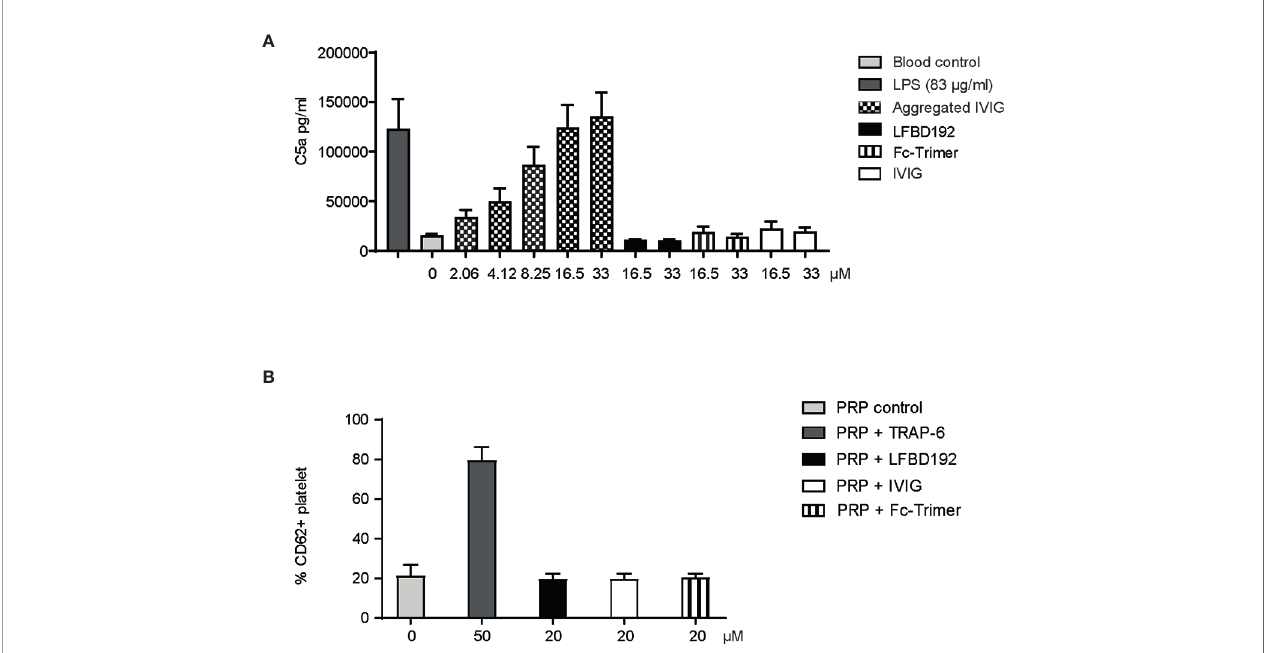
FIGURE 4 | LFBD192 does not trigger in vitro immune reactions relating to complement and platelet activation. (A) C5a generation in human whole blood in response to lipopolysaccharide (LPS) (83 µg/mL), aggregated IVIg (2.06, 4.12, 6.25, 16.5, 33 µM), LFBD192 (16.5 and 33 µM), Fc-trimer (16.5 and 33 µM) and IVIg (16.5 and 33 µM) was quanti fi ed by ELISA. Data are mean ± SEM of 4 experiments from 4 different human donors, each experiment performed in duplicates. (B) Platelet activation in response to TRAP-6 (50 µM, positive control), LFBD192 (20 µM), and IVIg (20 µM). Bars represent the means of CD62P expression ( ± SD) as measured by fl ow cytometry of 2 experiments from 2 different human donors, each experiment performed in